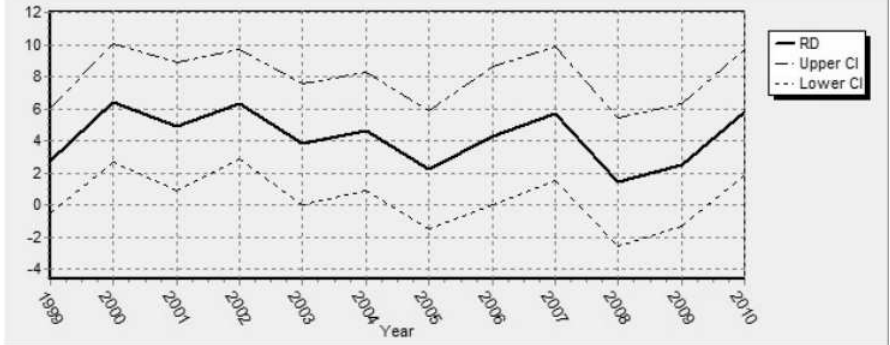
Figure 4. Trends of rate difference of age-standardised mortality rates among women in Świętokrzyskie, years